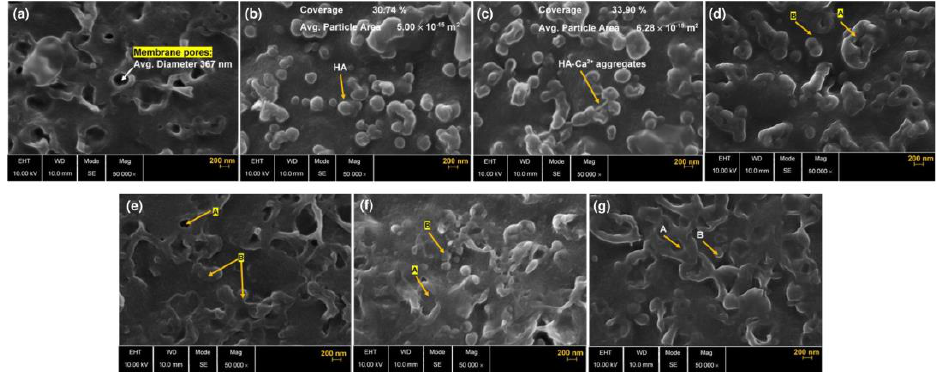
Figure 4. High-resolution scanning electron microscopy images illustrating surface morphology of ( a ) activated AEM (anion exchange membrane) after immersing the virgin membrane in 0.001 M NaCl for 24 h, ( b ) AEM fouled by HA (humic acid) and ( c ) AEM fouled by HA-Ca 2+ . Aggregated HA-Ca2+ foulants on/in AEM pores are labeled, ( d ) 2% ( w / w ) NaCl-desorbed, HA-fouled membrane and ( e ) 2% ( w / w ) NaCl-desorbed, HA-Ca2+-fouled membrane, ( f ) 0.03% ( w / w ) SDS (sodium dodecyl sulfonate)-desorbed, HA-fouled membrane and ( g ) 0.03% ( w / w ) SDS-desorbed, HA-Ca 2+ -fouled membrane. Label A presents recovered AEM pores by desorption and label B shows the remaining foulant after desorption. Reprinted with permission from Ref. [41] under the terms of the Creative Commons Attribution 4.0 International License (http://creativecommons.org/licenses/by/4.0/ (accessed on 26 December 2022)). Copyright © 2021 Published by Elsevier B.V.